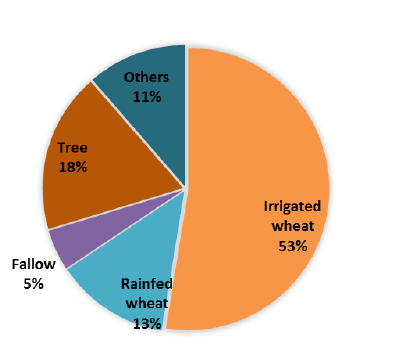
Figure 4. Statistics in the 16-m cropland map during the winter- spring irrigation period of 2018